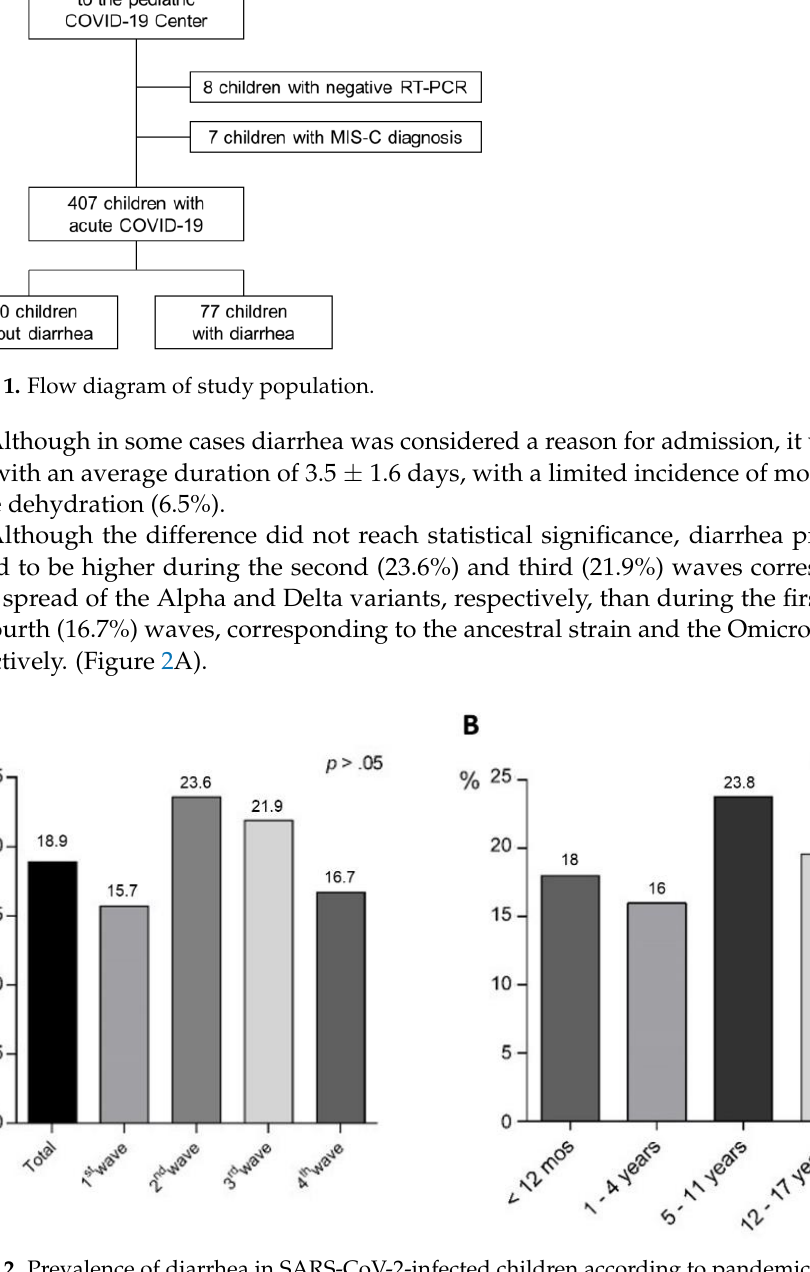
Figure 2. Prevalence of diarrhea in SARS-CoV-2-infected children according to pandemic waves ( A ) and child’s age ( B ). χ2 test was used to compare groups.